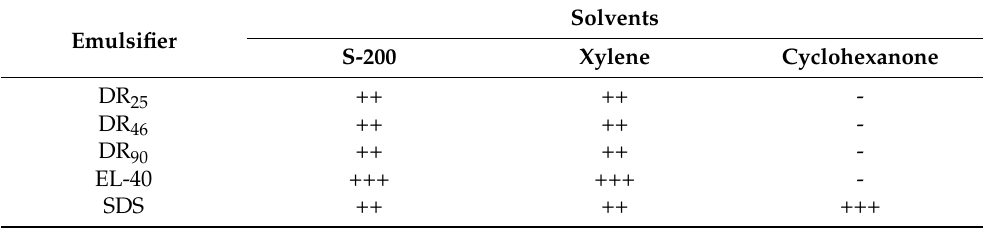
Table 2. Emulsification results of rhamnolipid products and chemical emulsifiers (SDS, EL-40) a .